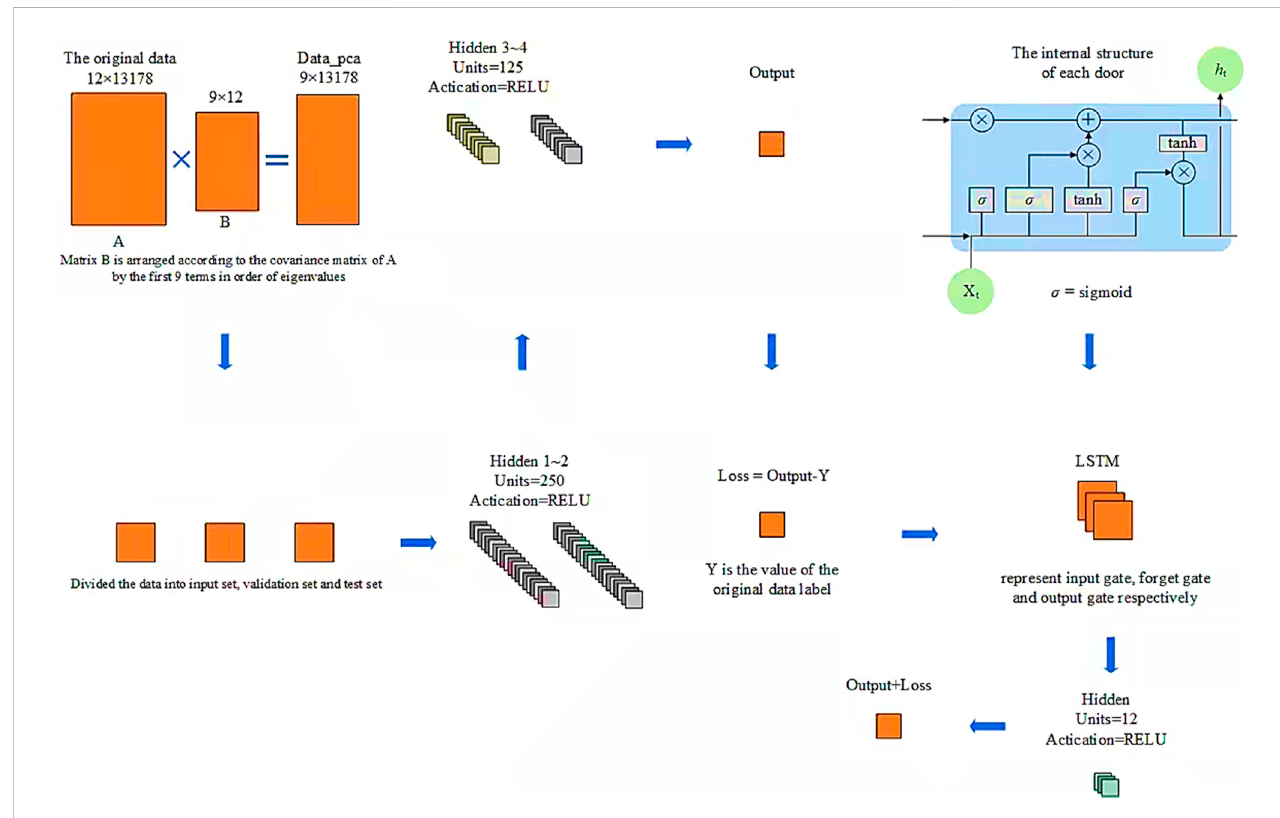
FIGURE 2 The structure diagram for detecting the potential